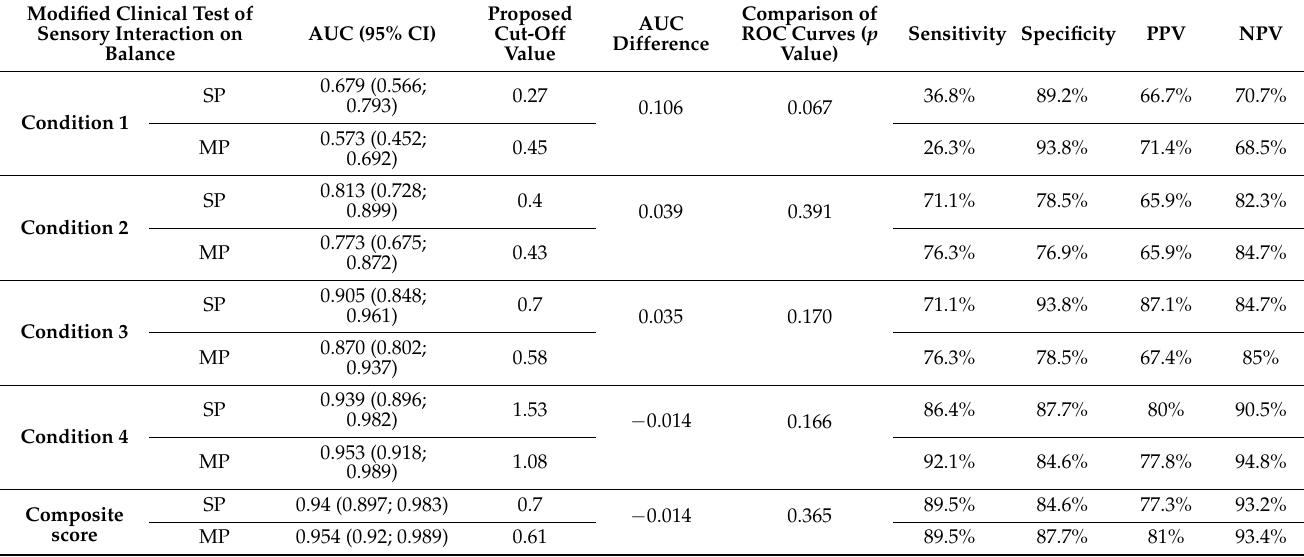
Table 4. Median values of angular velocity under four posturography conditions measured by mobile posturography (MediPost) and static